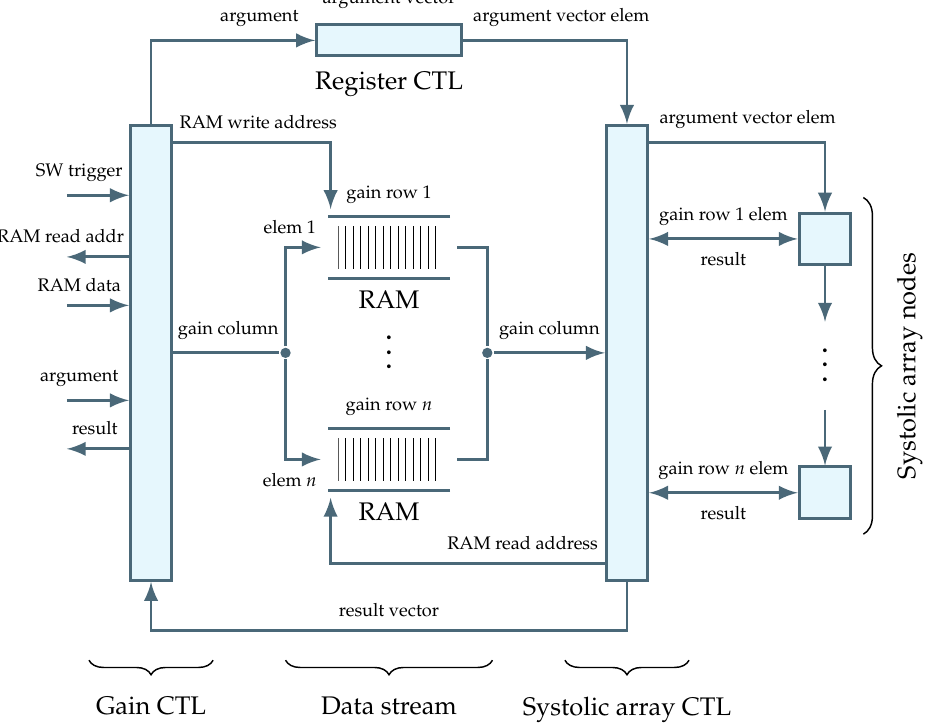
Figure 16. Gain entity schematic showing internal data